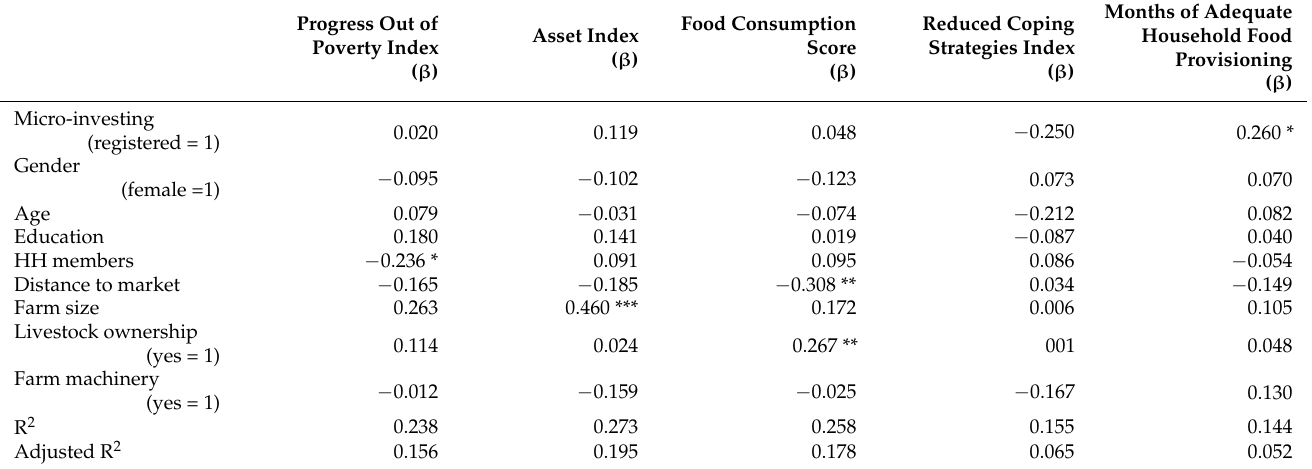
Table A1. Results of estimation of MI program participation as a determinant of poverty in Babati-rural. Progress Out of Poverty